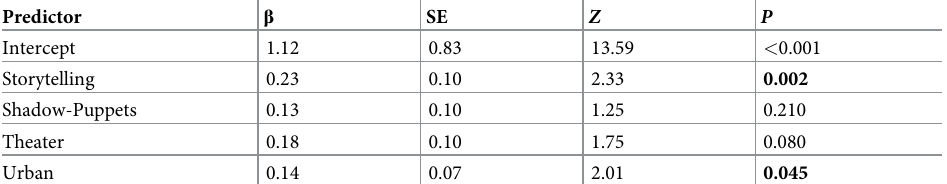
Table 2. Results of the GLMM examining the effectiveness of each technique on children’s learning about howler monkey behavior, ecology, and conservation at schools from Mexico.